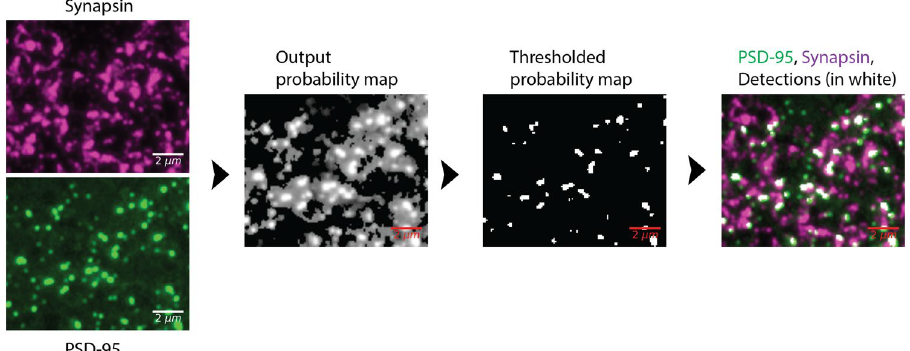
Figure 2. Probabilistic synapse detection pipeline. The first column shows the raw PSD-95 and synapsin data. The second column shows the output of the synapse detection method, where the value at each pixel is the probability that pixel belongs to the specified definition of a synapse. The third column shows the results of thresholding the output probability map. From our past work, we determined an empirical threshold of 0.9 to be the optimal value. The forth column shows the detections (in white) overlaid upon the superposition of the PSD-95 and synapse data. For this visualization, the definition of a synapse was the adjacency of a PSD-95 and synapsin punctum of a minimum size of 0.2 μ m × 0.2 μ m × 0.07 μ m which corresponds to 2 px × 2 px × 1 slice . Adjacency is defined as two puncta occupying immediately adjacent pixels, or sharing a small proportion of the